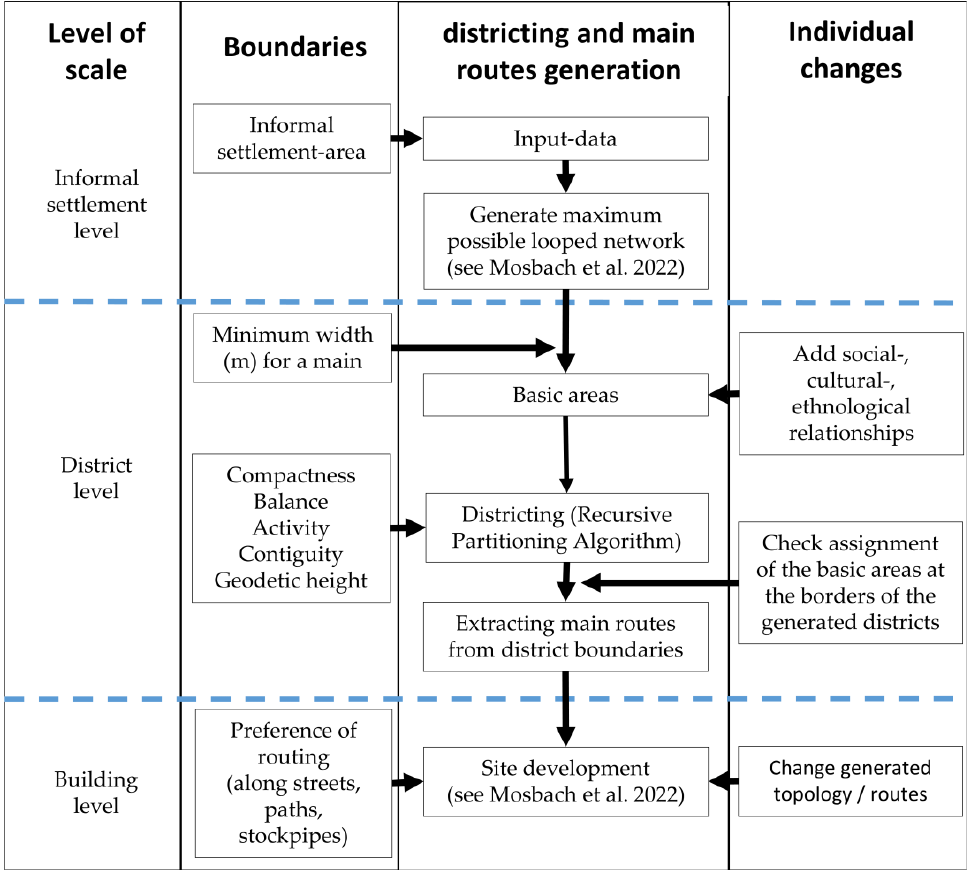
Figure 1. Overview and structure of the method (Mosbach,